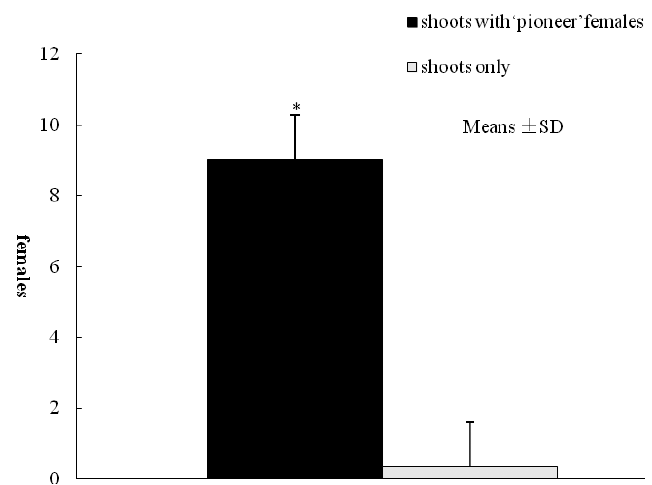
Figure 1. Oviposition selection of gravid females of Cephalcia chuxiongica in pine shoots with vs. with- out ‘pioneer’ females. *Indicates a statistically significant difference ( P < 0.05) between mean numbers of delivery females on the shoots with and without 'pioneer' females (non-parametric Wilcoxon matched pairs test, two-tailed).